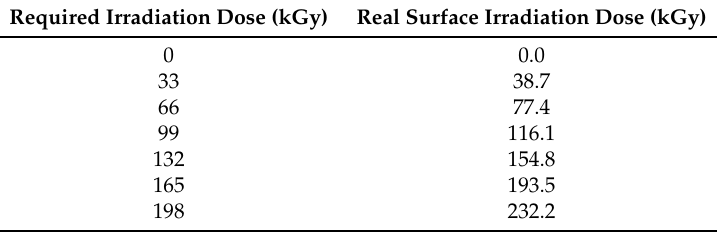
Table 2. Irradiation dose of TPE-E and